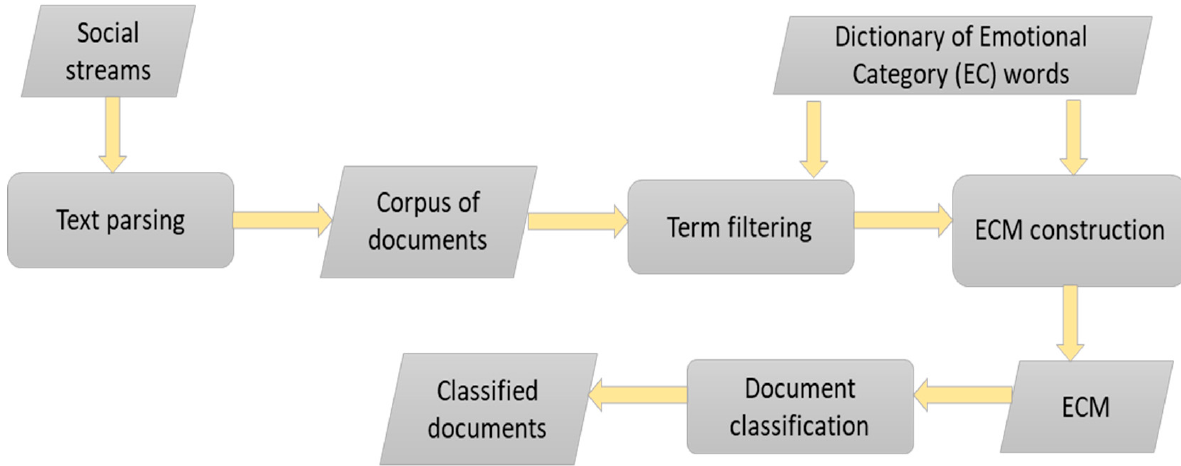
Figure 3. Schema of the social messages emotion classification framework proposed in [6].